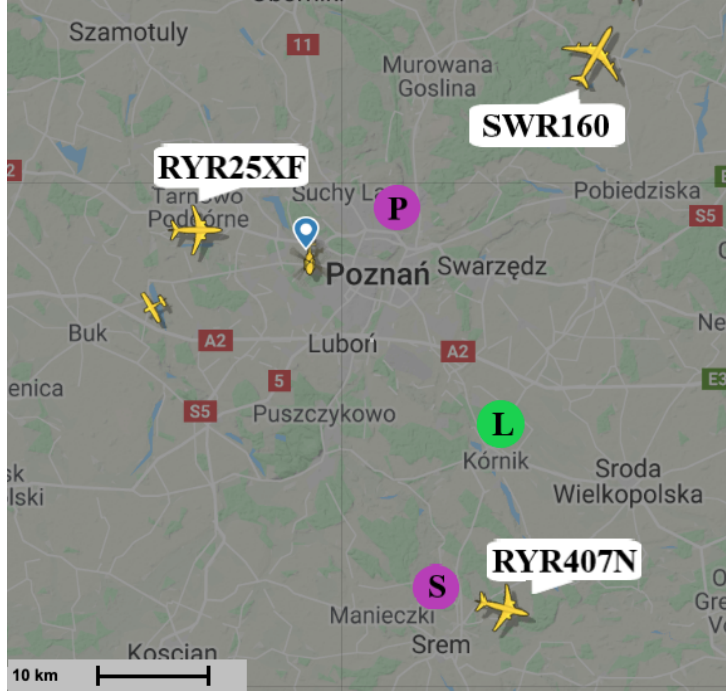
Figure 9. Situation in the air during measurement—April 2019 [39].